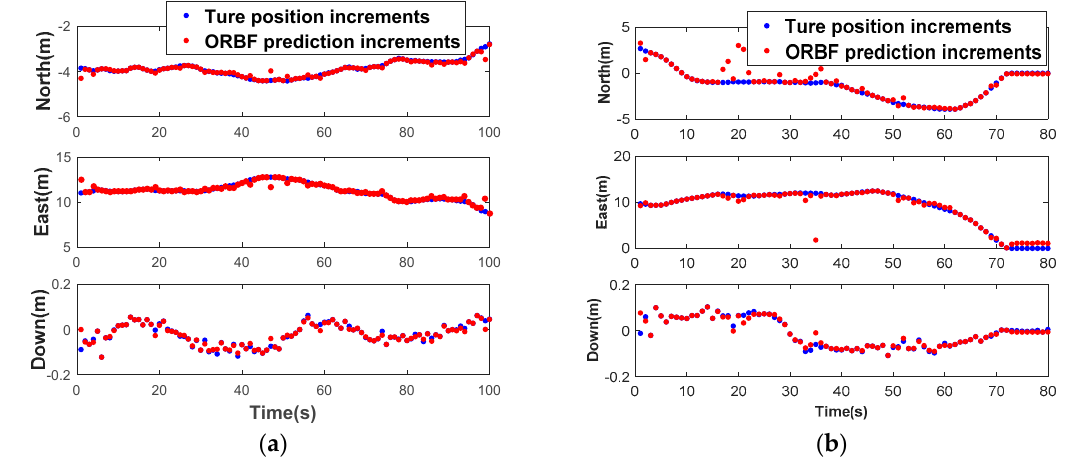
Figure 11. Prediction performance with ORBFNN algorithm in Test 1 ( a ) and Test 2 ( b ).